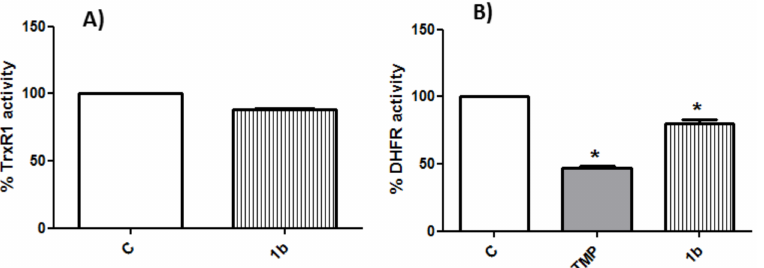
Figure 2. TrxR ( A ) and DHFR ( B ) activities after incubating E. coli lysates with gold complex 1b . Activities are represented as percentage respect to control (lysates without potential inhibitory compounds). Trimethoprim (TMP). * p <